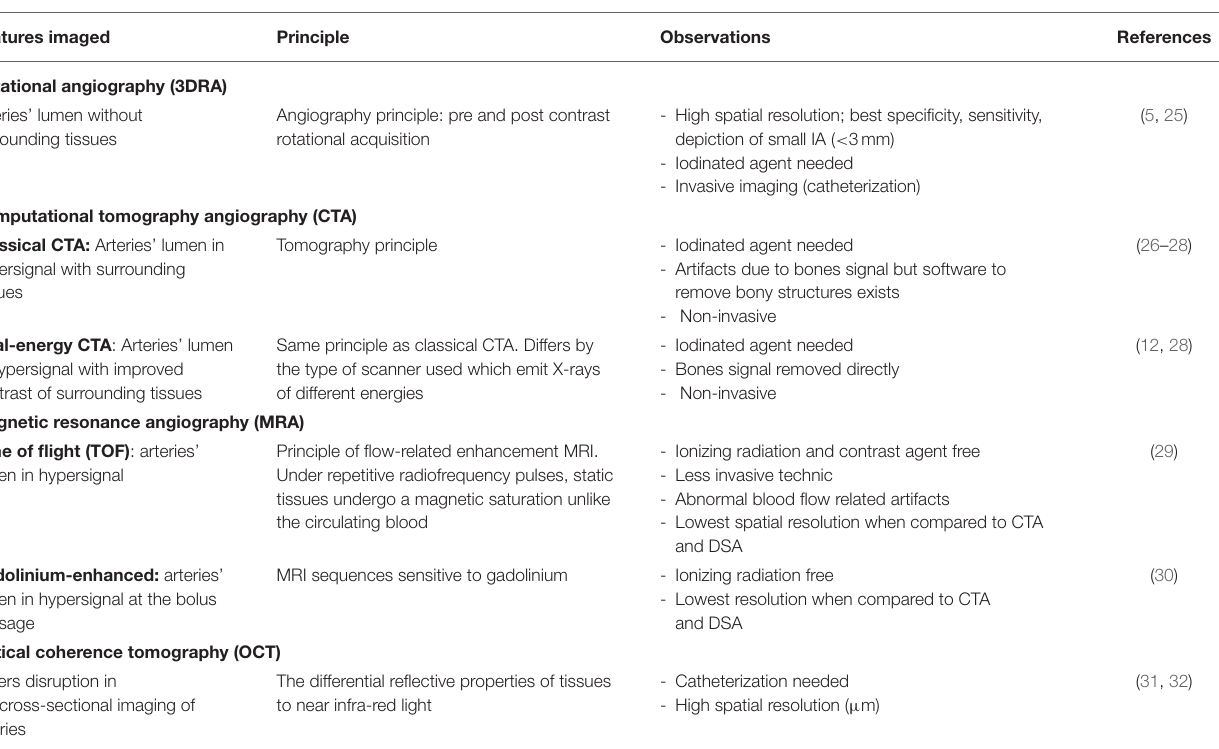
TABLE 1 | IA morphology imaging